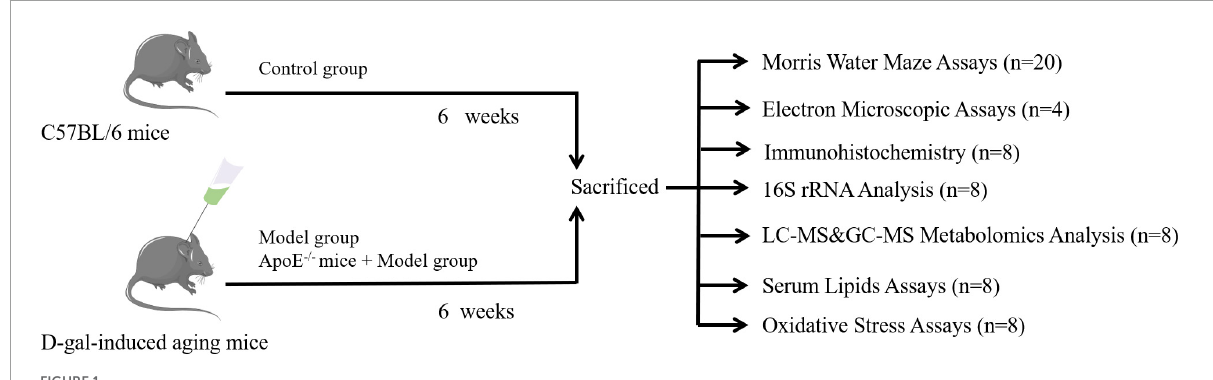
FIGURE1 Experimental